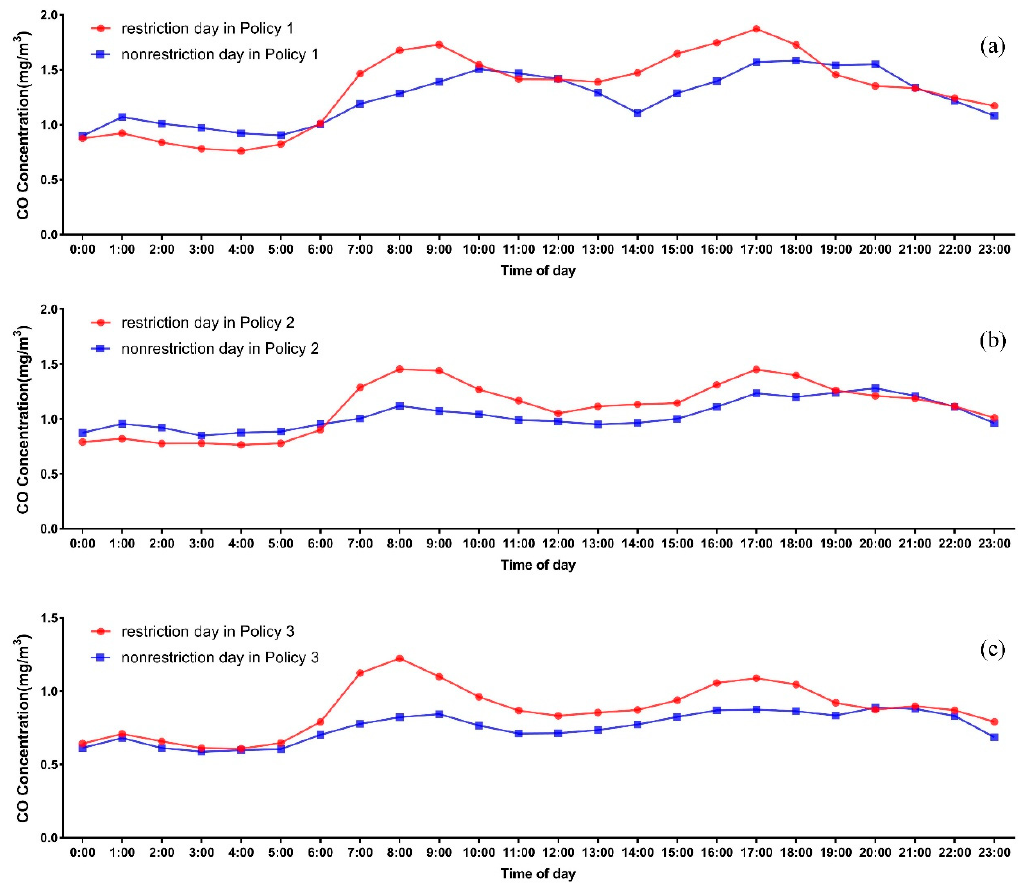
Figure 2. Comparison of CO concentration with different policies: ( a ) Policy 1; ( b ) Policy 2; and ( c ) Policy 3.